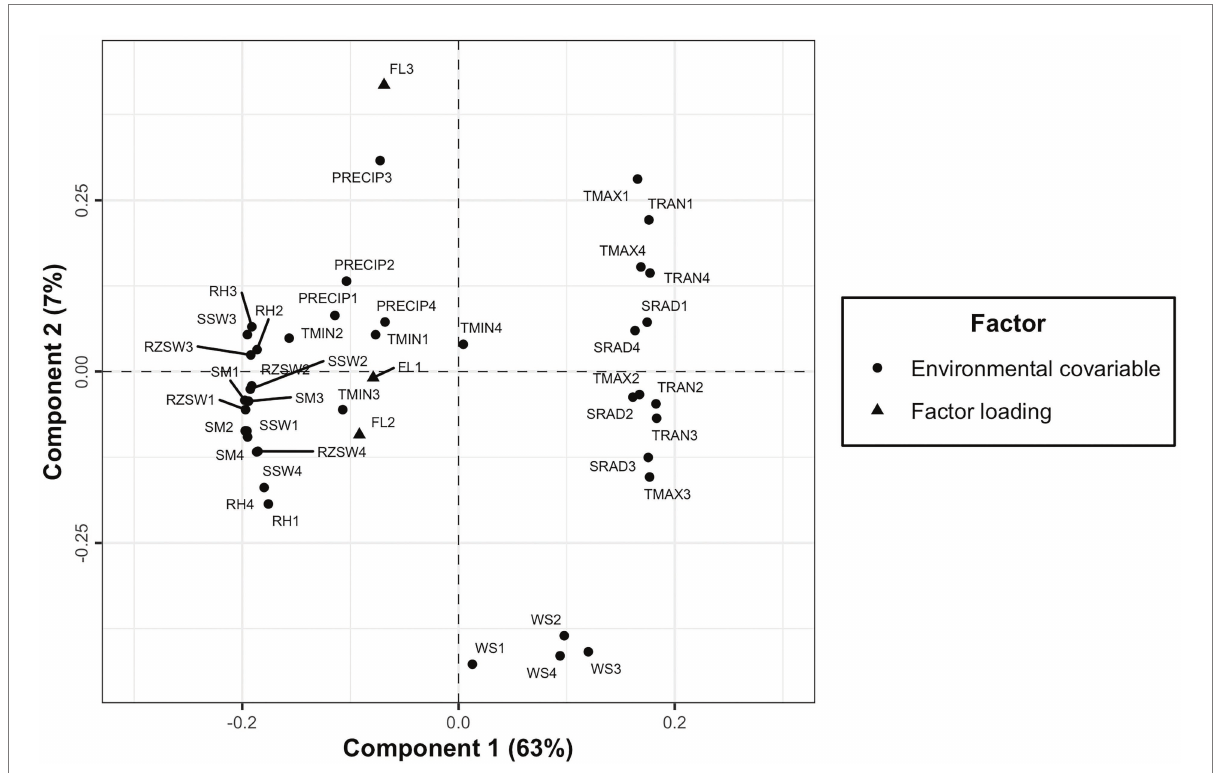
FIGURE 7 A plot of X and Y loadings revealing the association of factor loadings resulting from FA3 model to environmental covariables across four developmental phases of